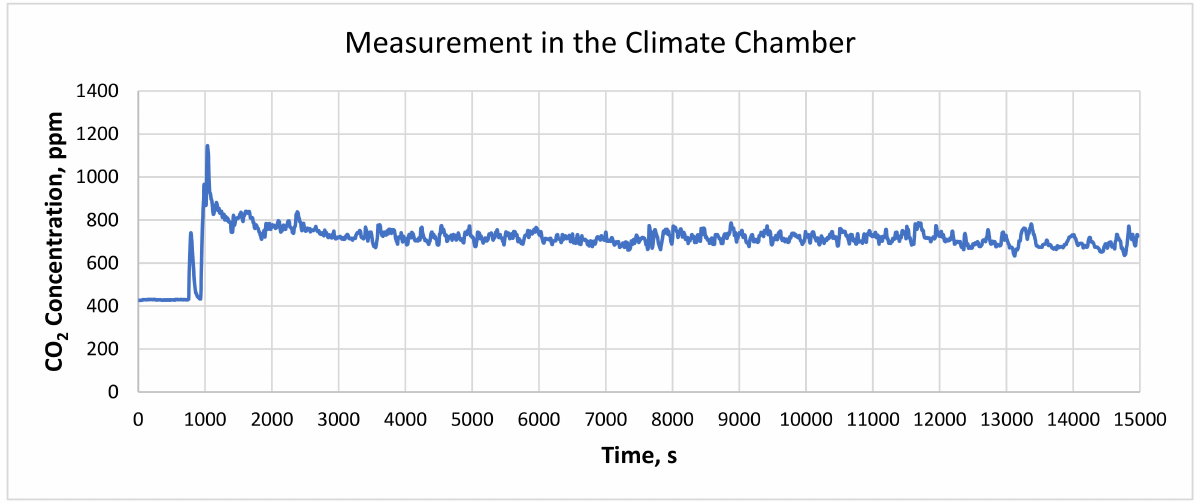
Figure 16. Carbon dioxide measurement in the climate chamber—the whole